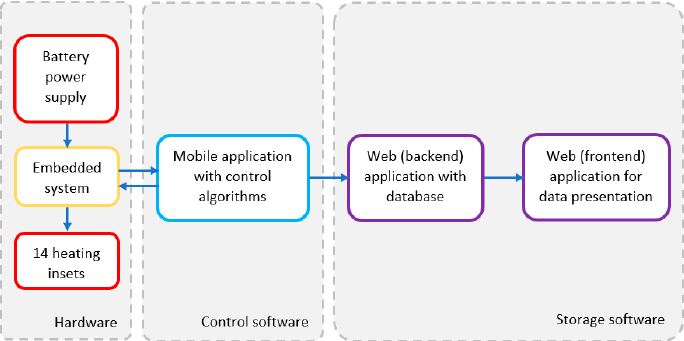
Figure 2. Block diagram of the system.